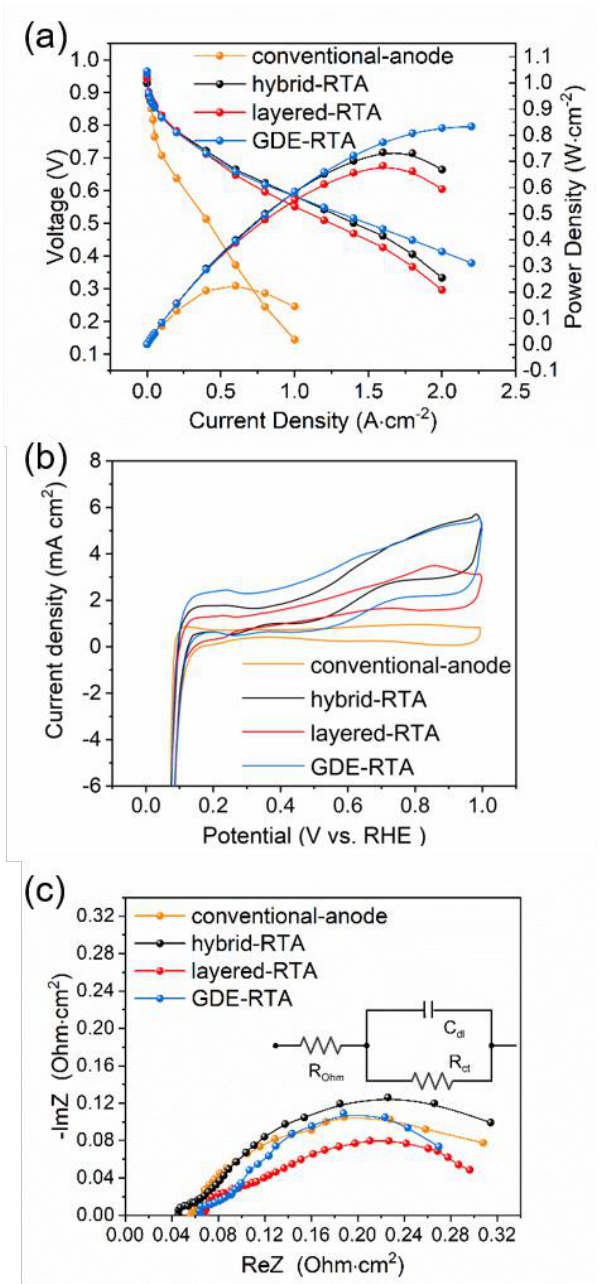
Figure 4. Electrochemical characterization of MEAs after cell reversal: AST, I–V, and power density curves ( a ), cyclic voltammograms ( b ), and Nyquist diagram ( c ).